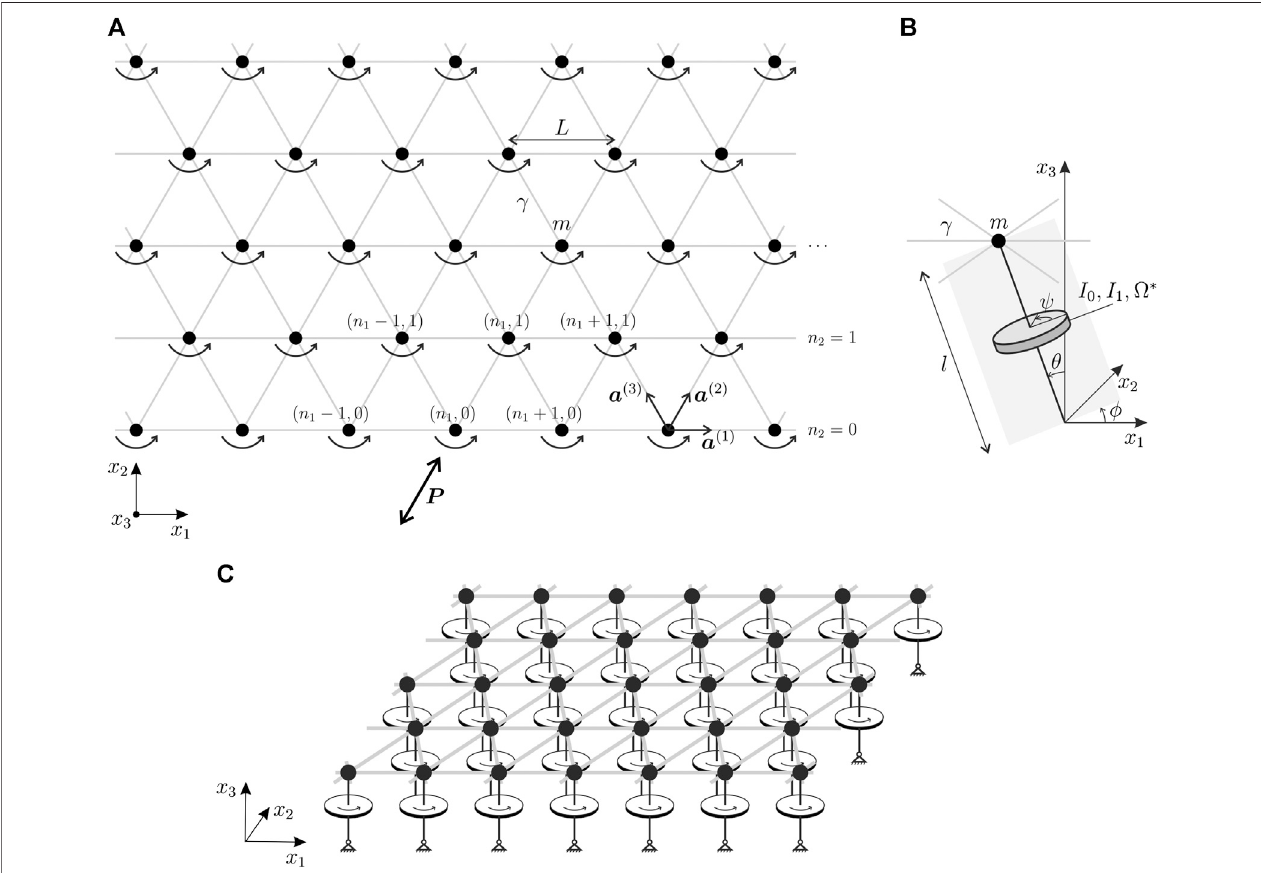
FIGURE1|(A) Semi-in fi nitetriangulararrayofmasses,interconnectedbyelasticlinksandjoinedtogyroscopicspinners;apointforceisappliedontheboundaryof the medium. (B) Representation of a gyroscopic spinner attached to a lattice ’ s mass; θ , ϕ and ψ indicate the nutation, precession and spin angles, respectively. (C) Three-dimensional sketch of the gyro-elastic